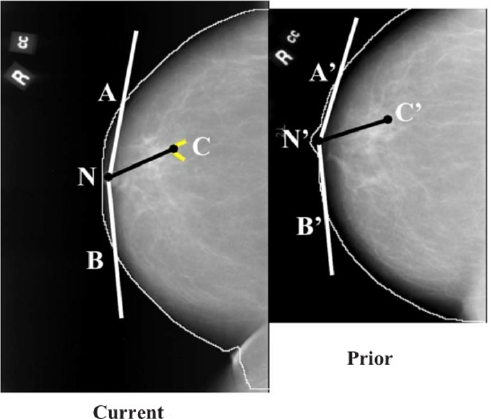
Figure 7. Initial estimation of the cluster centroid position in the prior mammogram based on the nipple-cluster distance and the angle between the nipple-cluster axis and breast periphery in the current mammogram (reprint with permission from